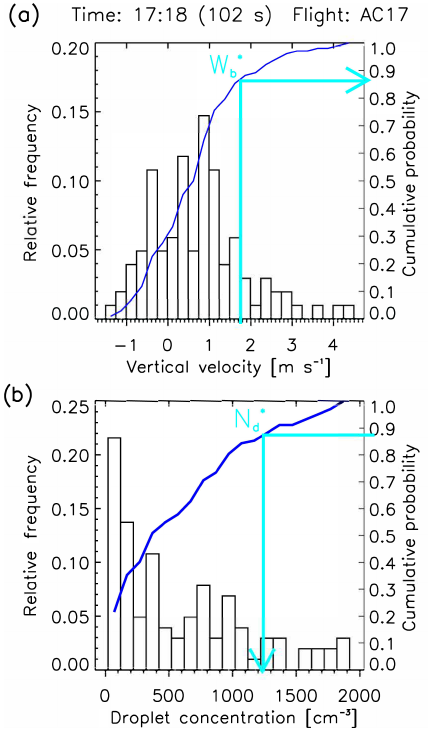
Figure 7. (a) Frequency histogram of vertical wind speed ( W b ) from cloud base measurements on flight AC17 (labeled on the left ordinate). The blue line indicates the cumulative probability func- tion of W b (labeled on the right ordinate). The cyan arrow indicates the value of W ∗ (1.83ms − 1 ) that represents the 86th percentile of b the W spectra. (b) A similar histogram for the cloud droplet concen- trations measured with the CCP-CDP probe. The cyan line indicates the N ∗ value (1207cm − 3 ) at the 86th percentile in the N d spectra. d The indicated time is in UTC and shows the time of the first cloud penetration at cloud base and the total number of 1s measured cloud data